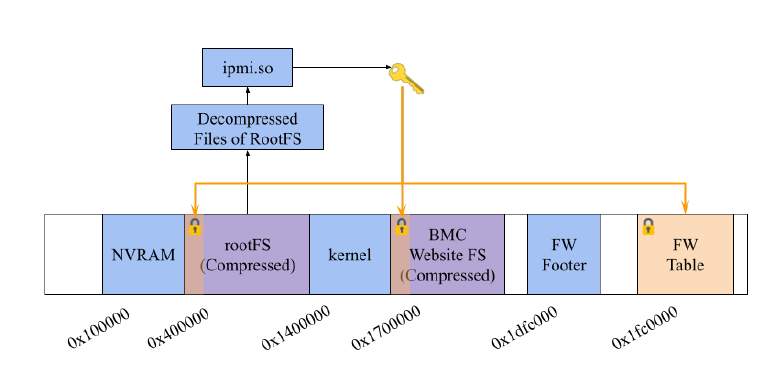
Figure 4: Layout of the BMC firmware upgrade package. The NVRAM region stores the current configuration of the BMC, the rootFS is a LZMA-compressed cramFS file system with only its header encrypted. The kernel region stores a Linux kernel image, while the BMC website FS is another compressed file system with only the file system header encrypted. The FW Footer starts with a magic value ATENs_FW and contain information about the firmware version, checksum, etc. The FW Table is an encrypted region and stores a table of the image layout. All encrypted region of the firmware can be decrypted with a key extracted from ipmi.so on the rootFS .